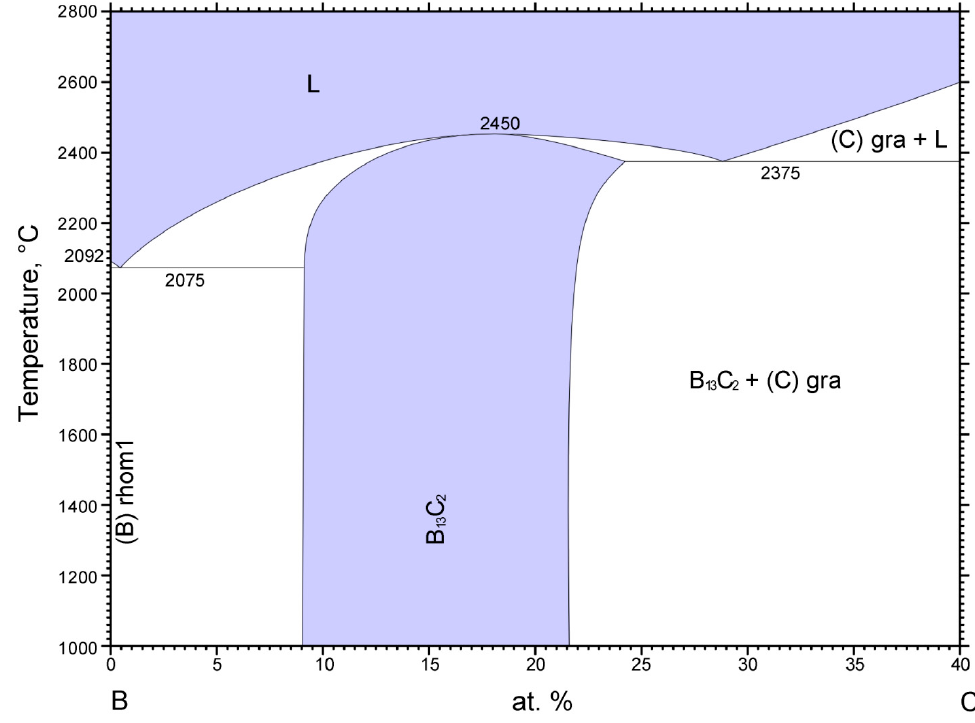
Figure 9. Boron-carbon phase diagram